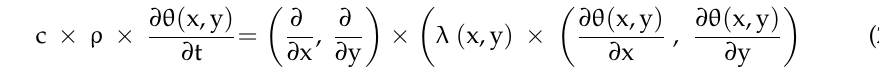
Figure 8. Model of a fragment of a structure with a generated mesh.